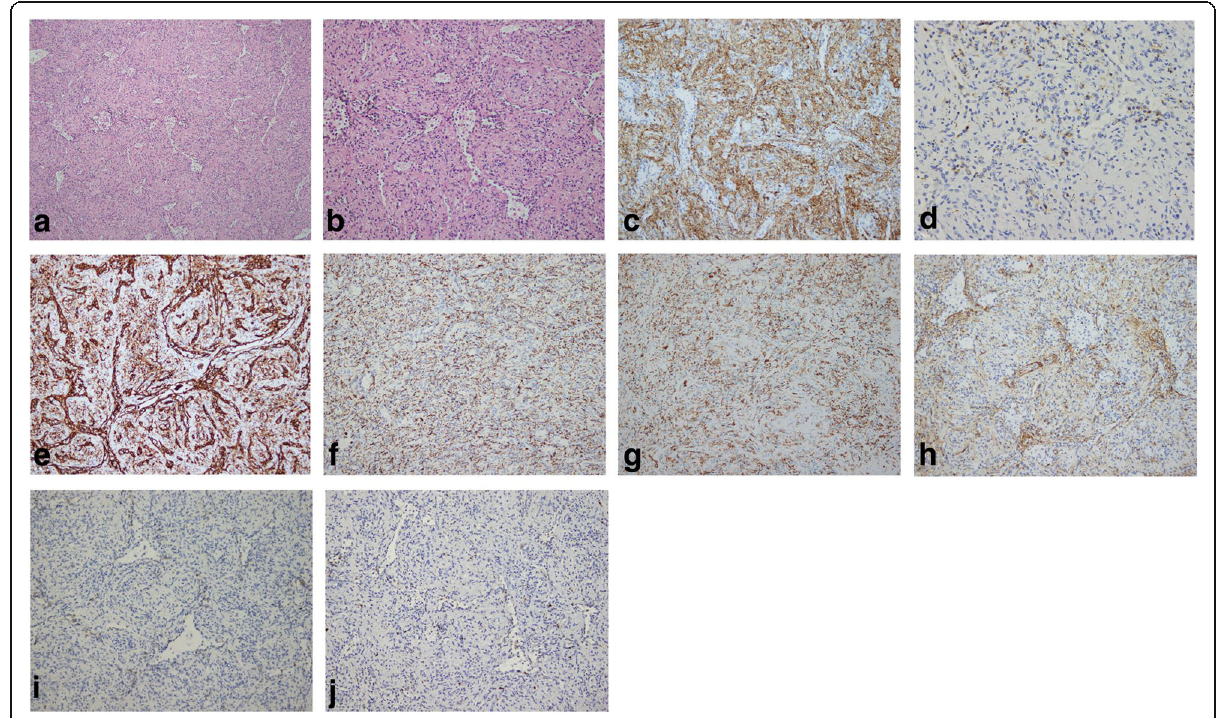
Fig. 4 Microscopical features and immunohistochemistry of the pathological sections of the spleen. The Hematoxylin-Eosin staining (( a ) H&E staining ×2; ( b ) H&E staining, ×200) shows multiple small nodules formed by proliferative spindle cells without obvious cellular atypia or mitotic figures. The immunostaining revealed 3 distinct types of vessels in the angiomatoid nodules: CD34 − /CD8 − /CD31+ small veins, CD34 − /CD8+/CD31+ sinusoids, and